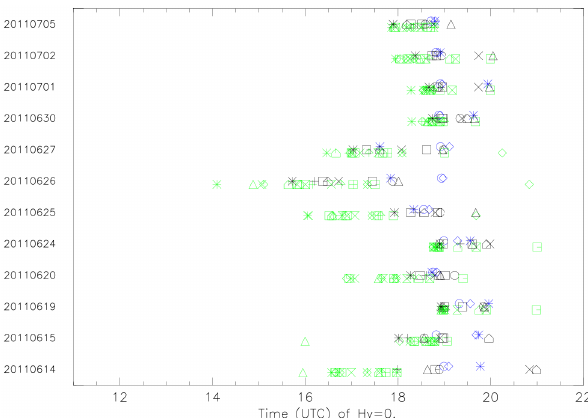
Figure 11. Time (on the x axis) when the virtual temperature flux becomes negative for surface stations observations (black symbols), the ARPEGE grid points (blue symbols) or the AROME grid points (cyan symbols) for each IOP plotted on the y